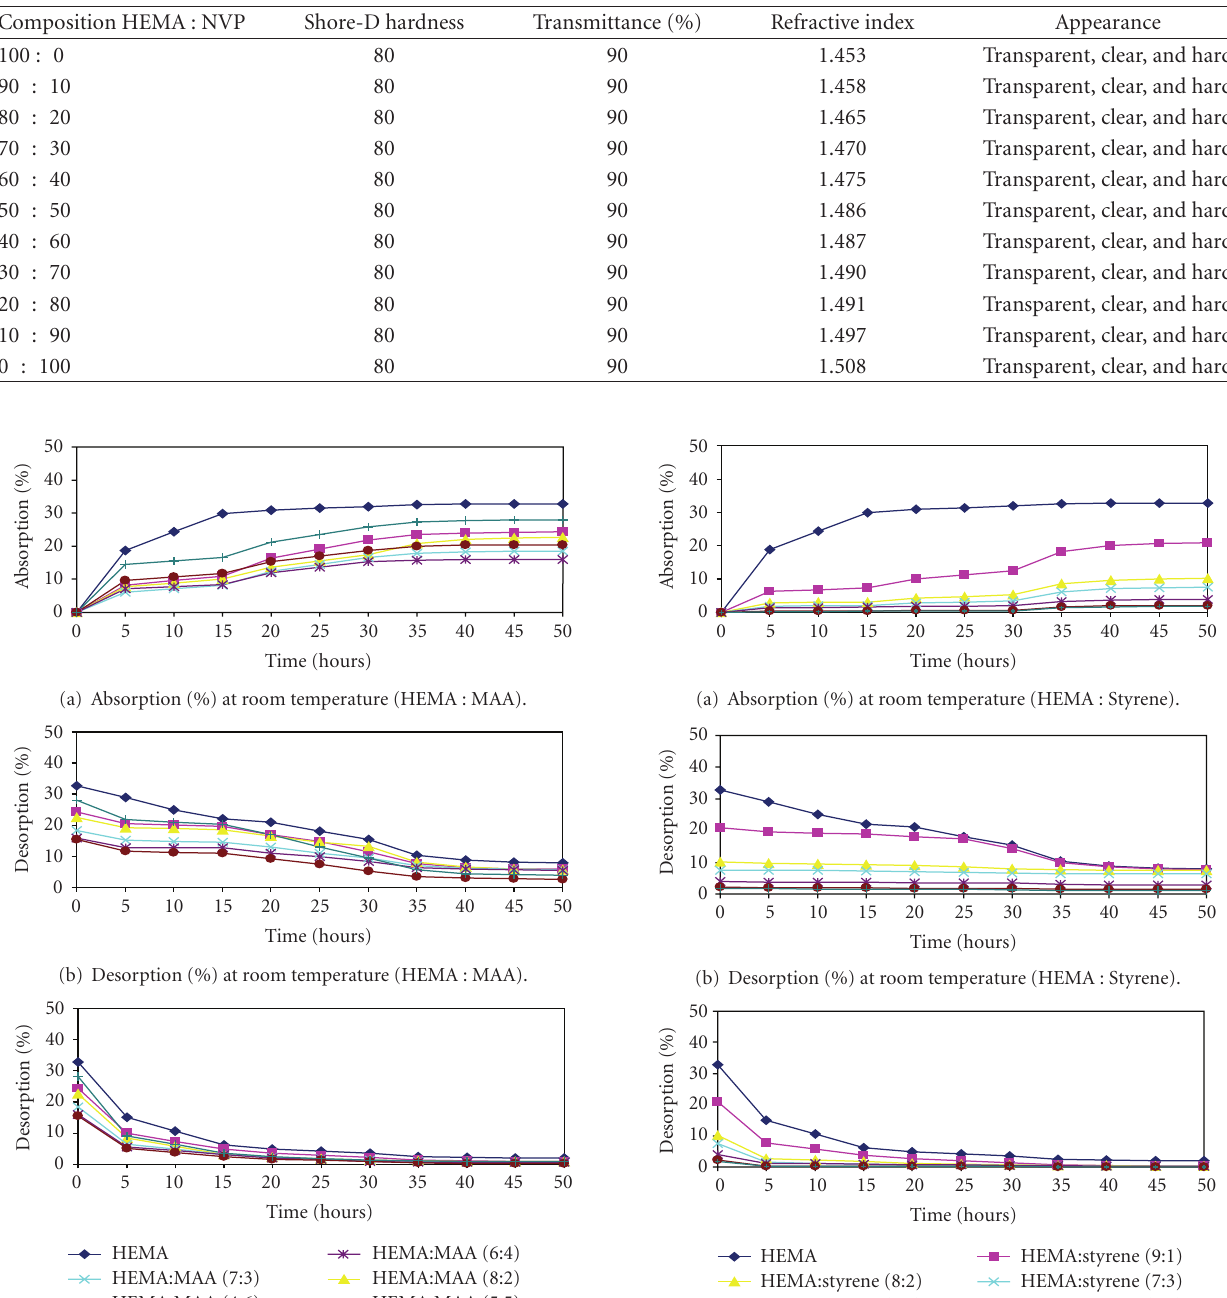
Table 6: Properties of polymers obtained with HEMA: NVP by varying ratios.